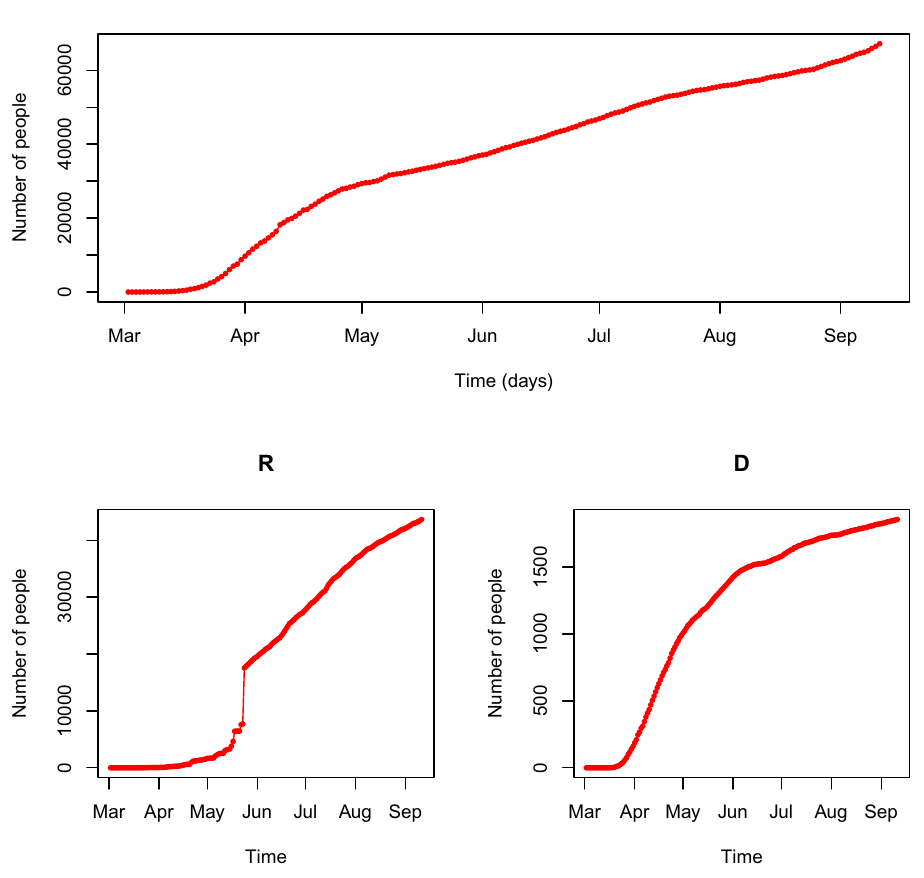
Figure 4. Course of the COVID-19 epidemic in Portugal. ( a ) Confirmed infected cases (cumulative). ( b ) Recovered cases (cumulative). ( c ) Deaths (cumulative).